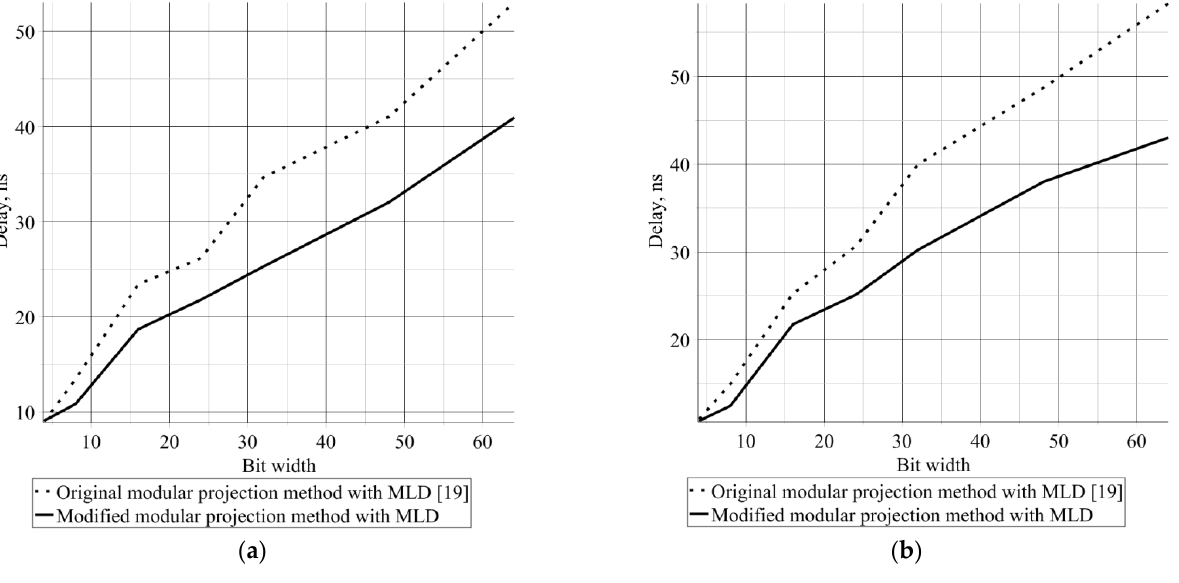
Figure 3. Time to correct errors and restore numbers in WNS: ( a ) single error, ( b ) double error.